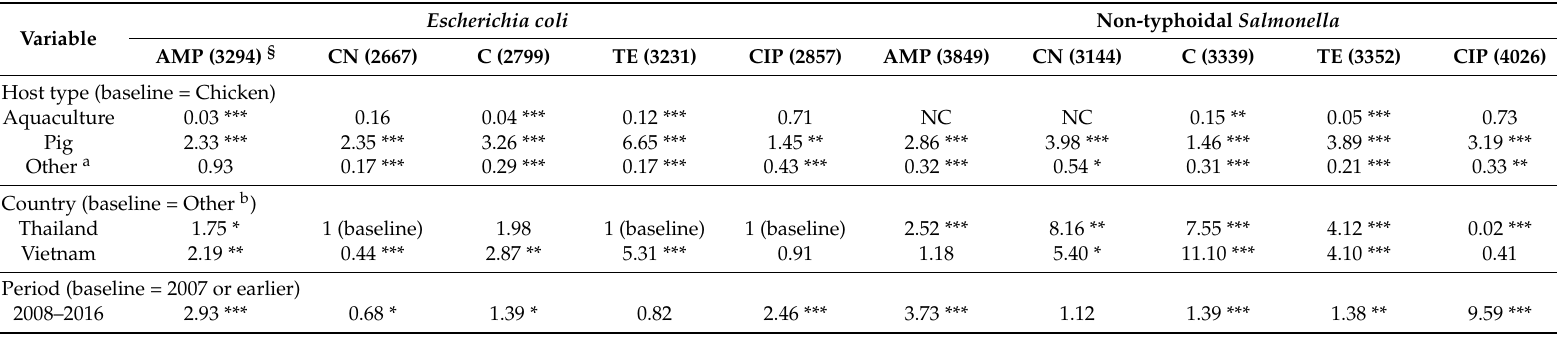
Table 1. Odds ratios (ORs) derived from multivariable logistic regression models investigating risk factors for positivity among Escherichia coli and non-typhoidal Salmonella (NTS) isolates against five antimicrobials in Southeast Asia (SEA). The reported p -values refer to the significance levels of the investigated